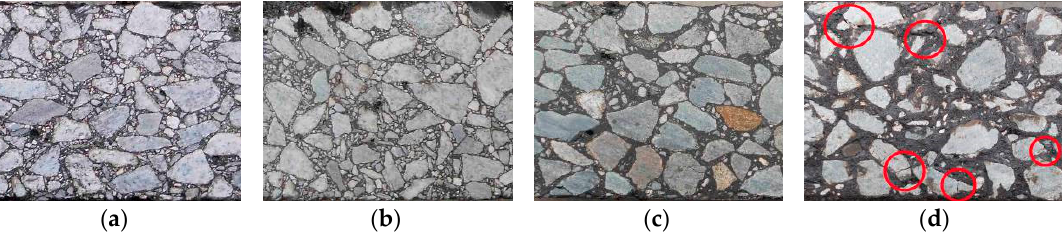
Figure 4. Original cross-sectional image and broken aggregates. ( a ) 70# asphalt AC-13C; ( b ) rock asphalt AC-13C; ( c ) SMA-13; and ( d ) broken aggregates. asphalt AC-13C; ( c ) SMA-13; and ( d ) broken